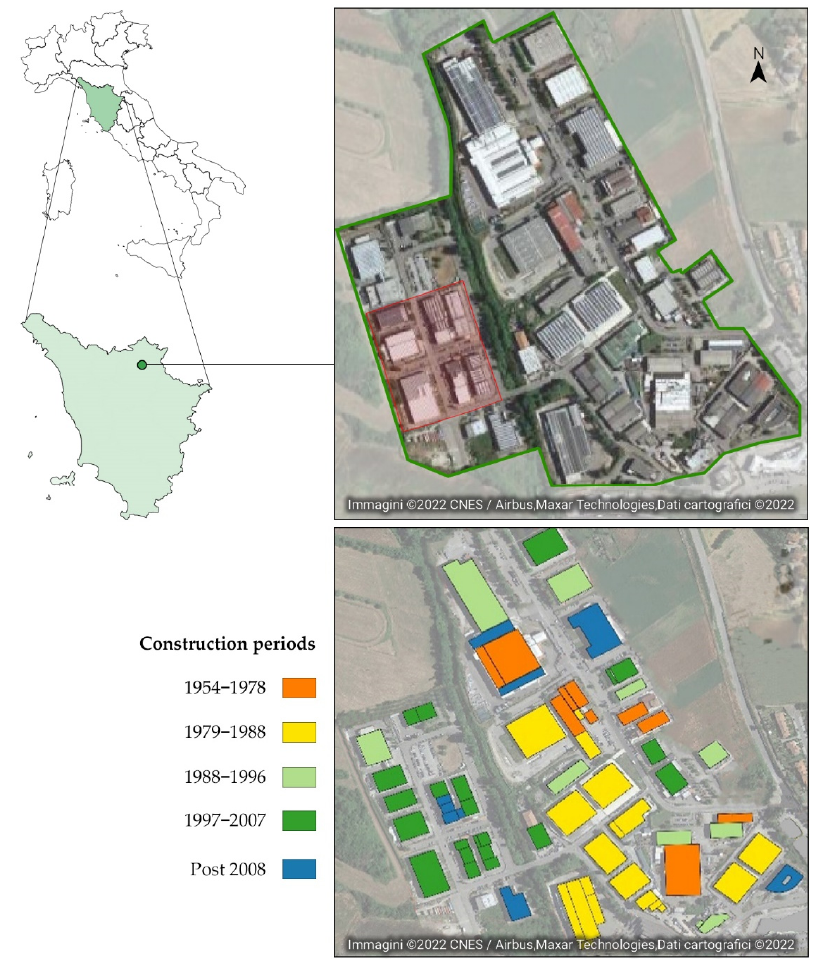
Figure 1. Aerial view of the case study area and its location in the regional and national territory. Within the area, M1 is highlighted with green borders while its internal subset M2, is colored in red. A classification of the buildings according to their construction periods is also provided.